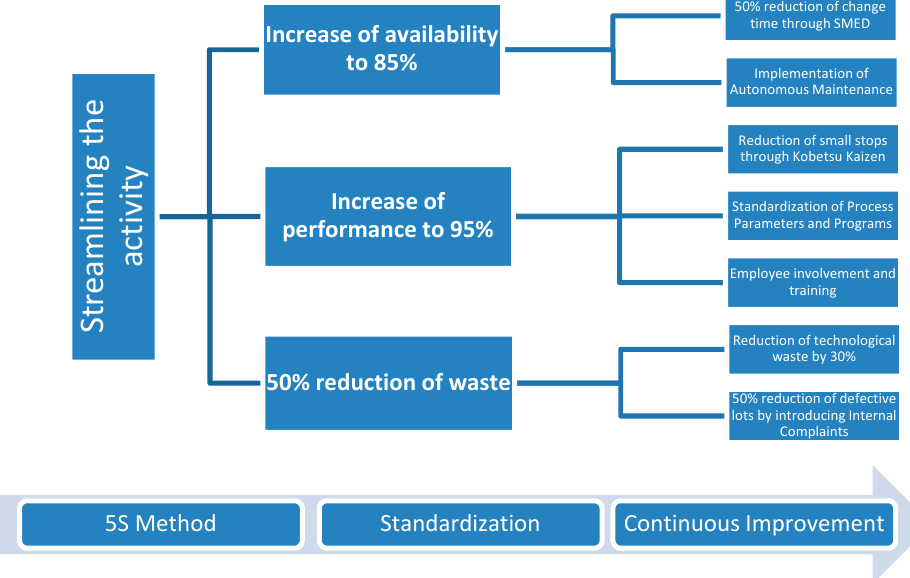
Figure 2. Cascading the main objectives set by the management team.